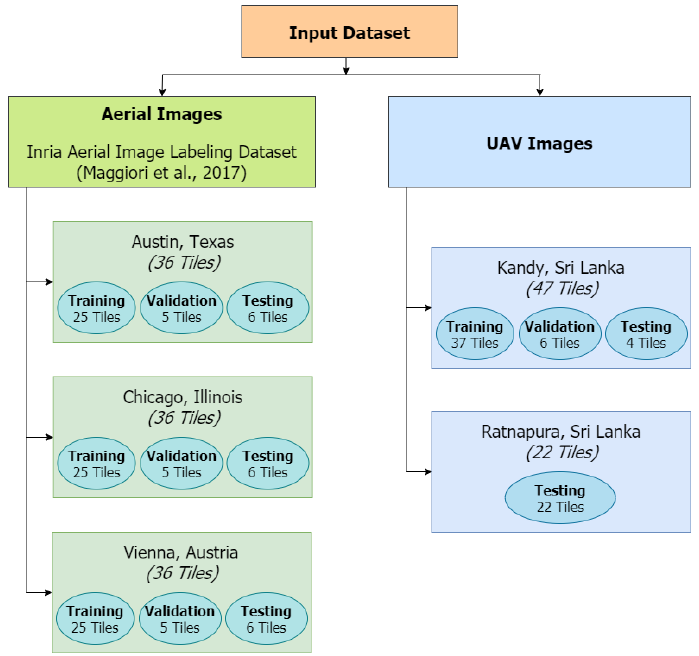
Figure 2. Datasets used.